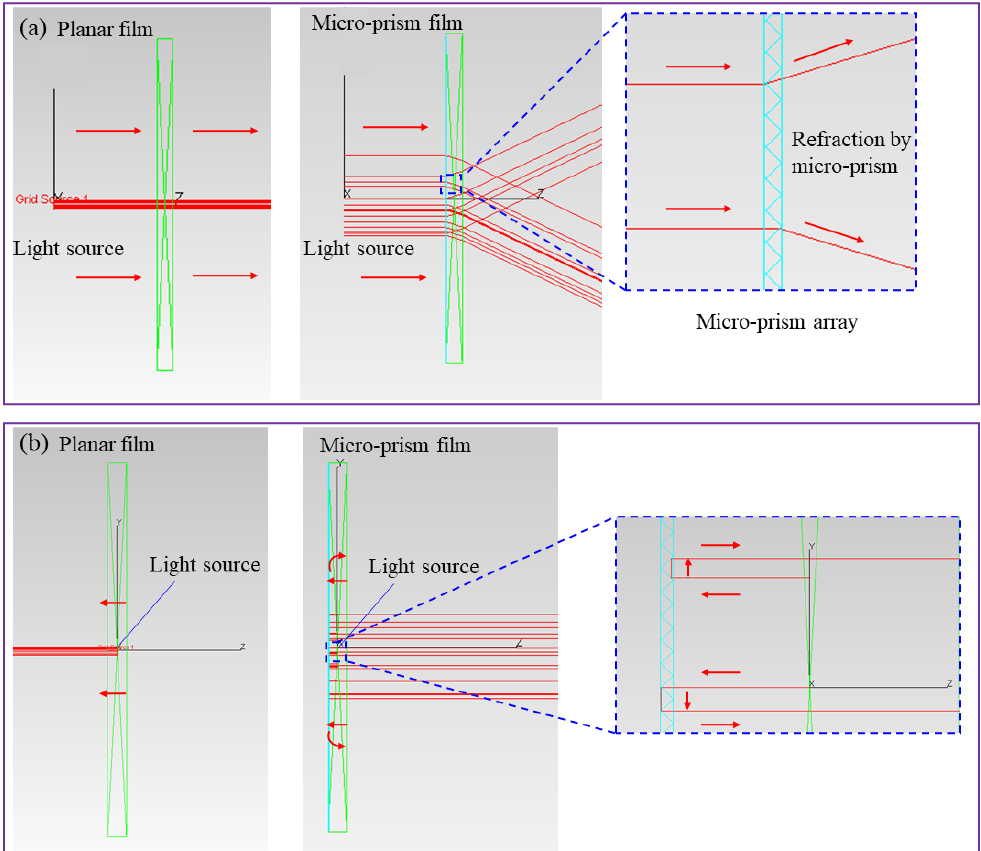
Figure 4. Schematic diagrams of ( a ) light propagation from air to incident surface (left: planar film; right: micro-prism film) and ( b ) light propagation from incident surface to air (left: planar film; right: micro-prism film).